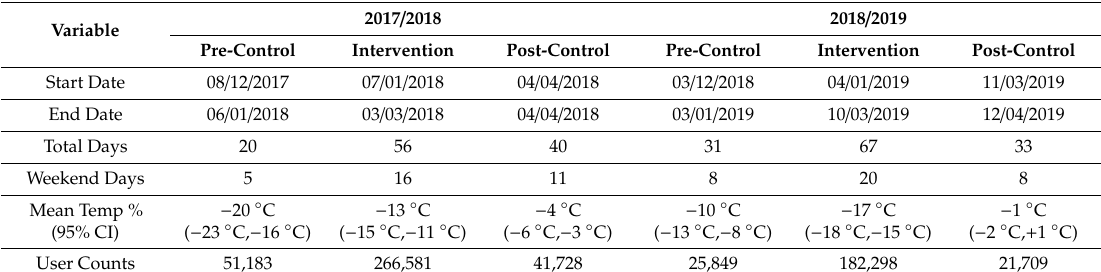
Table 1. Natural experiment details. CI, confidence interval.